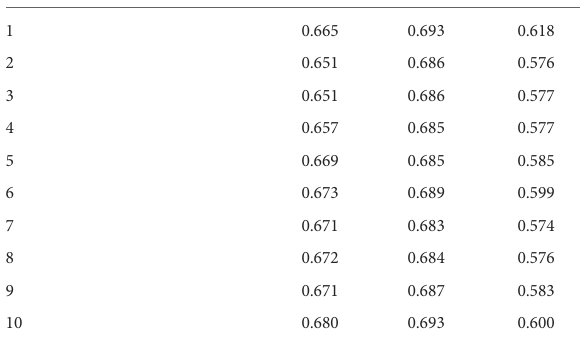
TABLE 3 The distributions of areas under the receiver operating curve (AUROC), accuracy, and precision with the cumulating number of top ten important factors associated with central obesity among school students.